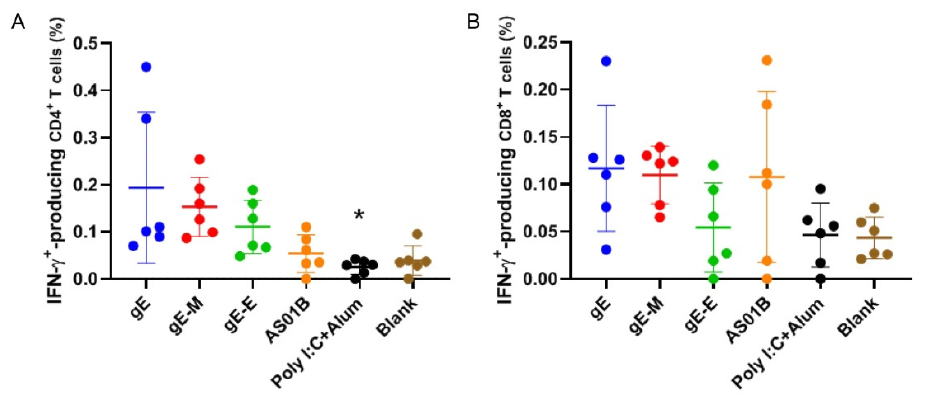
Figure 4. Flow cytometry assay for gE-specific IFN- γ -producing T cells. ( A ) Proportion of IFN- γ -producing CD4+ T cells among splenocytes after stimulation with gE; ( B ) proportion of IFN- γ -producing CD8+ T cells among splenocytes after stimulation with gE. Data were analyzed using one-way ANOVA followed by Dunnett’s multiple comparisons test, with the gE-M group as a control. * p < 0.05.